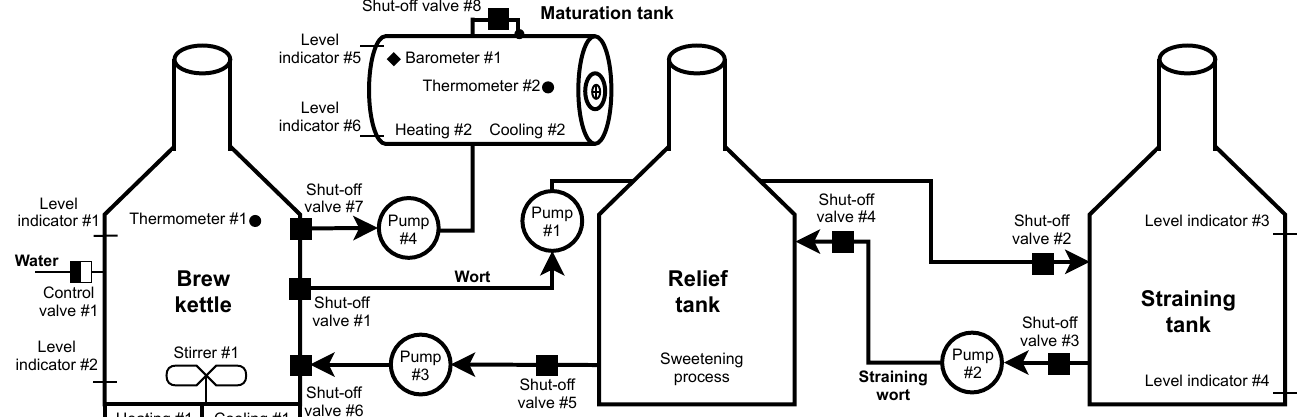
Figure 7. Diagram of physical brewery